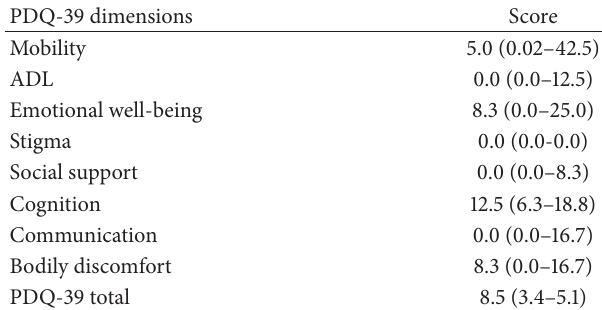
Table 3: Total scores of PDQ-39 dimensions.